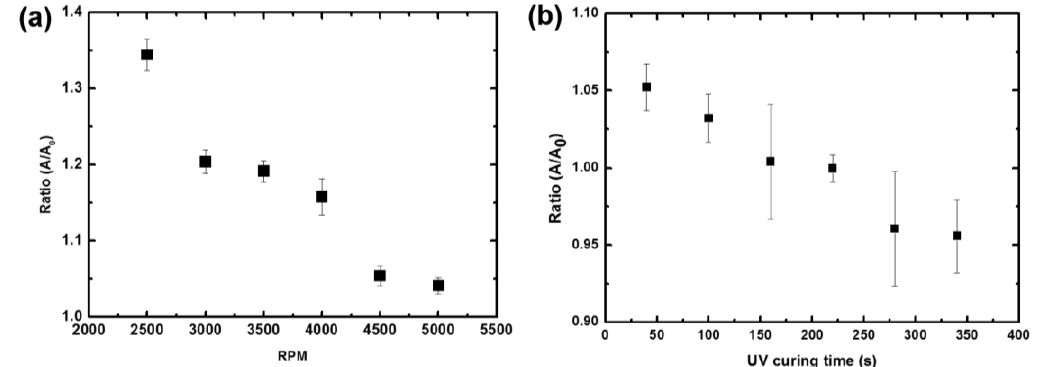
Figure 4. ( a ) A graph showing the ratio of the spreading area, compared to the design area. The ratio approaches unity when the spinning speed is high. ( b ) Ratio dependence on the ultraviolet (UV) curing